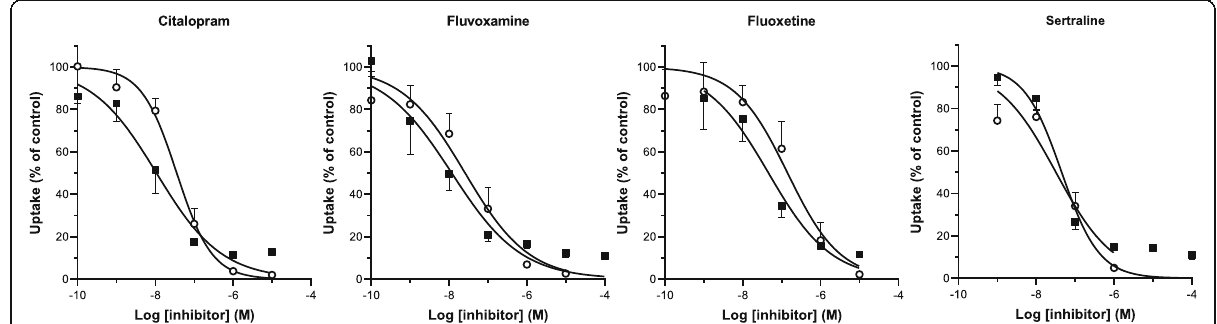
Fig. 4 Inhibition of [ 3 H]serotonin and [ 125 I]MIBG uptake by SSRIs in human platelets. Inhibition of [ 3 H]serotonin uptake is depicted by open symbols ( ○ ), and inhibition of [ 125 I]MIBG uptake by closed symbols ( ■ ). Samples were incubated at 37 °C for 15 min (serotonin) or 4 h (MIBG) with a substrate concentration of 10 − 8 M. Substrate uptake is expressed as the percentage of control without inhibitor.